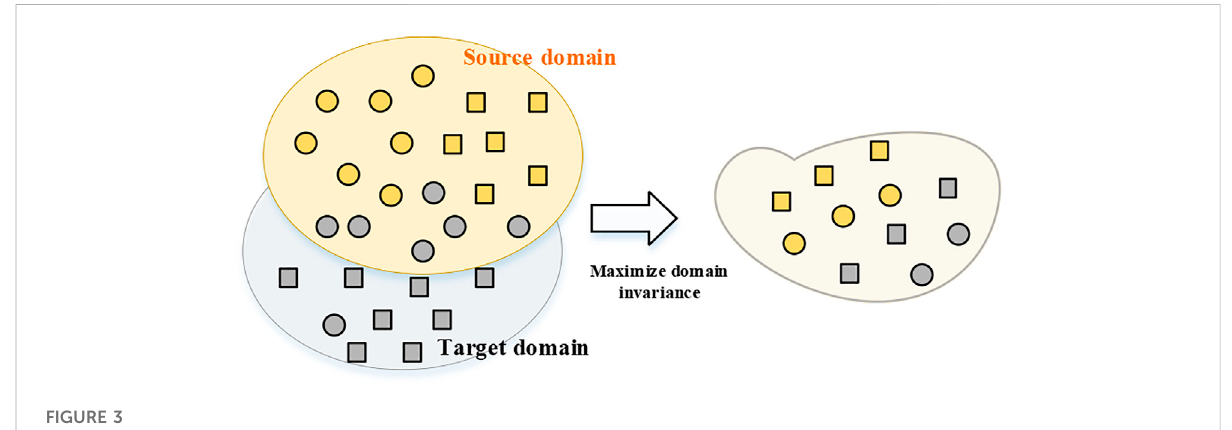
FIGURE 3 Schematic of feature-based transfer